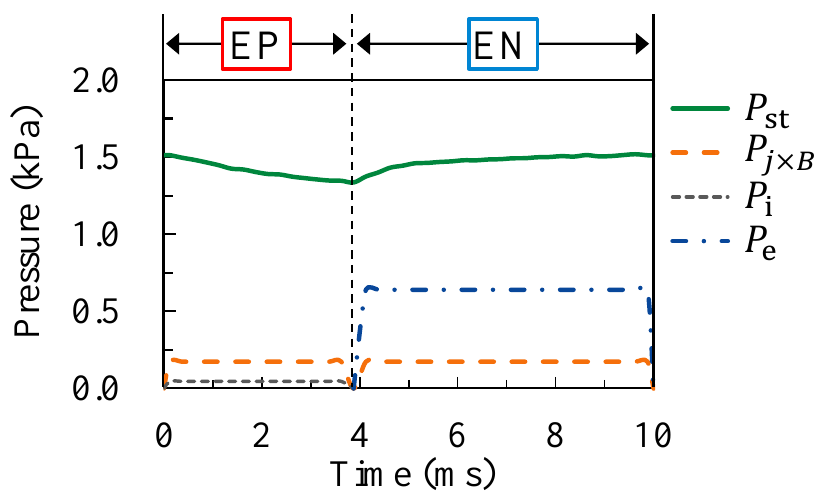
Figure 16. Estimated pressure balance acting on the molten electrode surface.